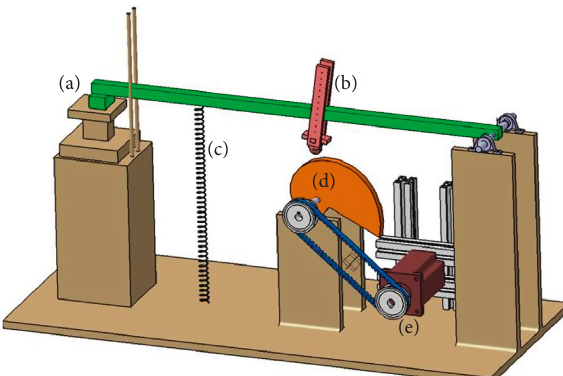
Figure 4: Motor-driven lever system: (a) mass; (b) sliding bar; (c) spring; (d) cam mechanism; (e) motor [17].